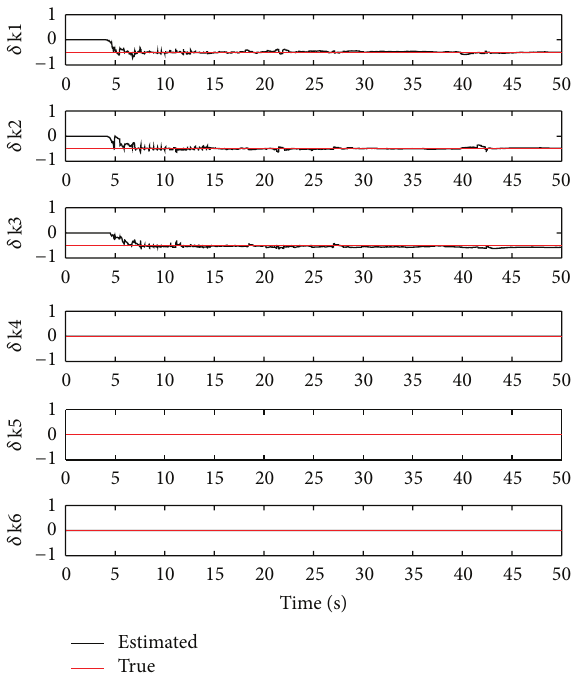
Figure 6: Damage stiffness estimation using multiple model approach ( 𝛾 𝑠 = 0.001 , 𝛾 𝑙 = 1000 , and 𝜖(𝛾 𝑠 ) = 0.03